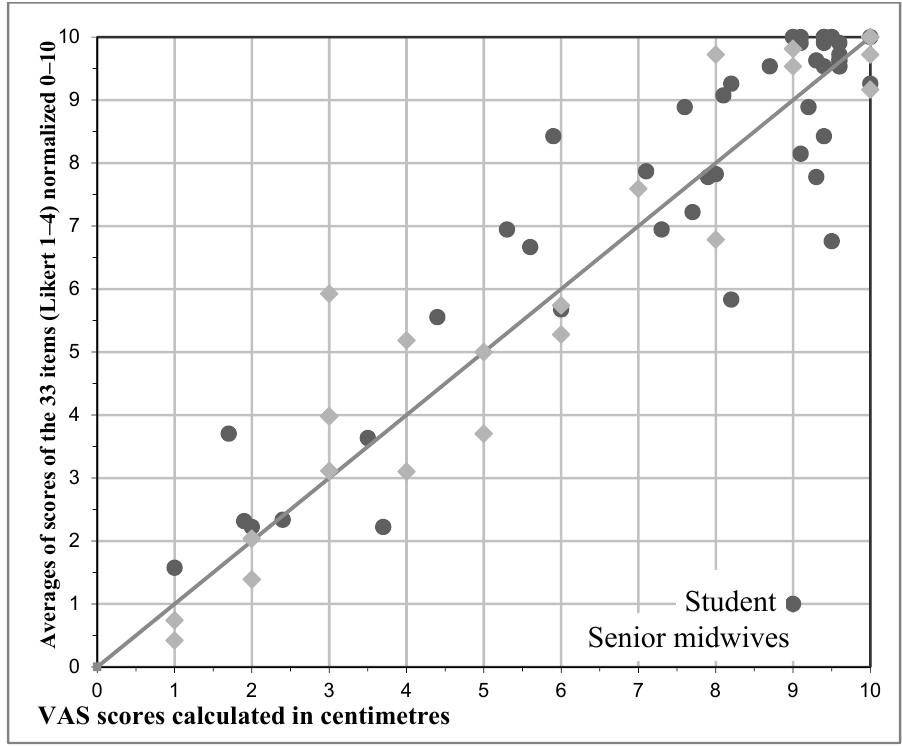
Figure 1. Pearson Correlation Coefficients: for the forms of the 10 preceptors who ≥ 4 evaluations from students, a comparison between the averages of scores of the 33 items (Likert 1–4), normalized 0–10 and VAS scores given by students and senior midwives calculated in centimeters was made, obtaining a Pearson Correlation Coefficient r = 0.78.